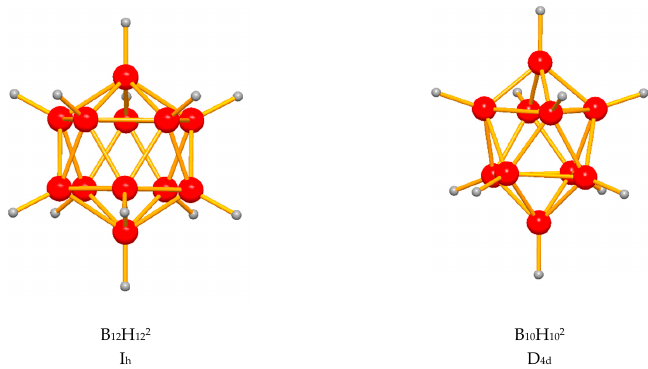
Figure 1. The two frequently used hydroborate anions: closo -dodecaborate ( left ) and closo -decaborate ( right ) and their point group symmetry.